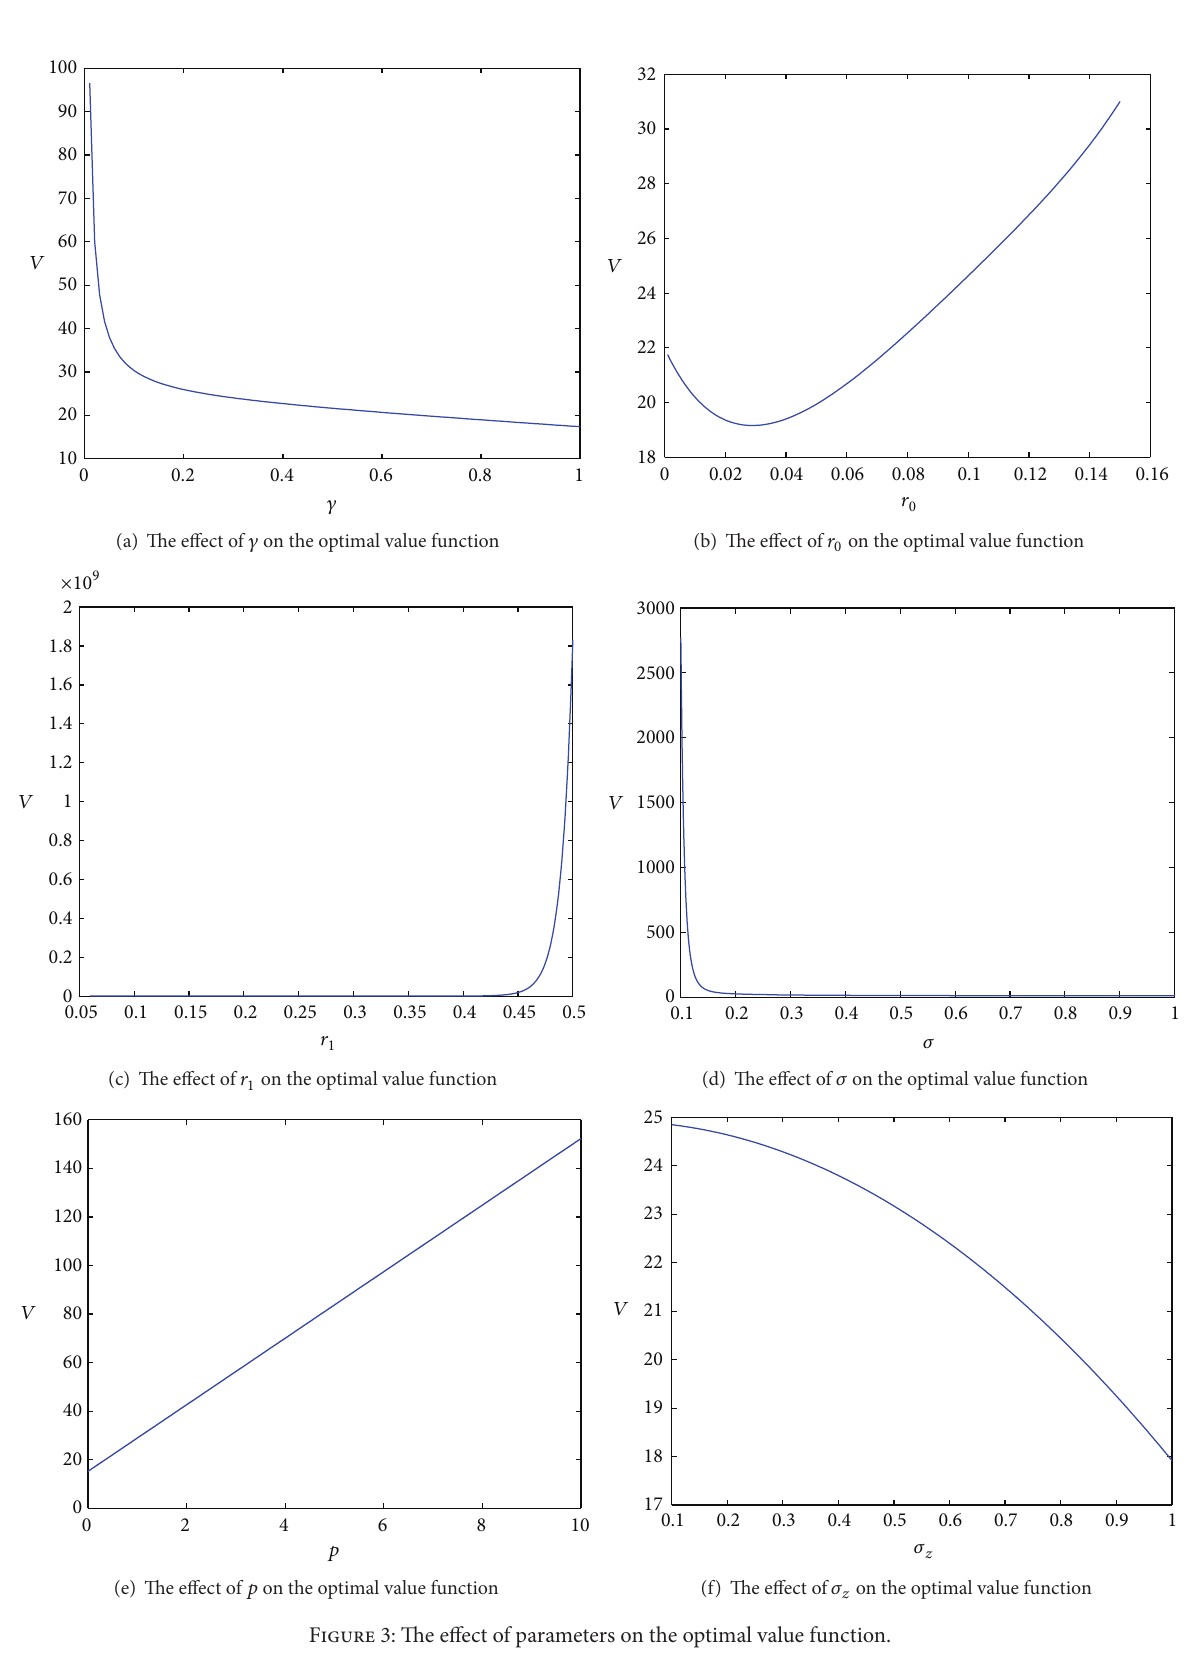
Figure 3: The effect of parameters on the optimal value